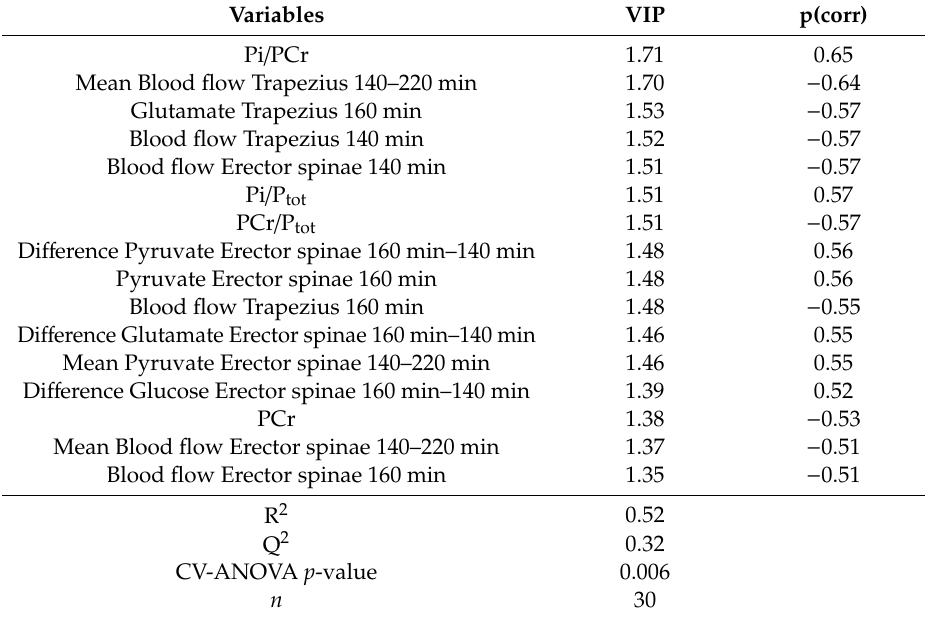
Table 6. OPLS of global pain intensity previous seven days in FM. Regressors used data from spectroscopy and microdialysis (except pain variables from microdialysis) (cf. Tables 3 and 4). The regression had one predictive component. Only significant variables are shown (i.e., variables with VIP > 1.0 and absolute p(corr) ≥